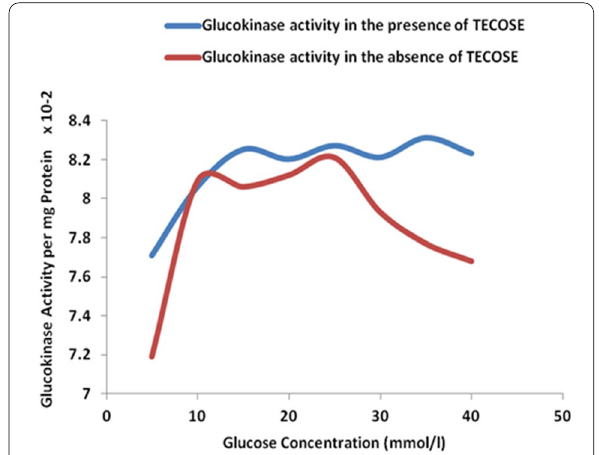
Fig. 7 Mode of glucokinase activity with and without incubation with Tetracarpidium conophorum seed extract